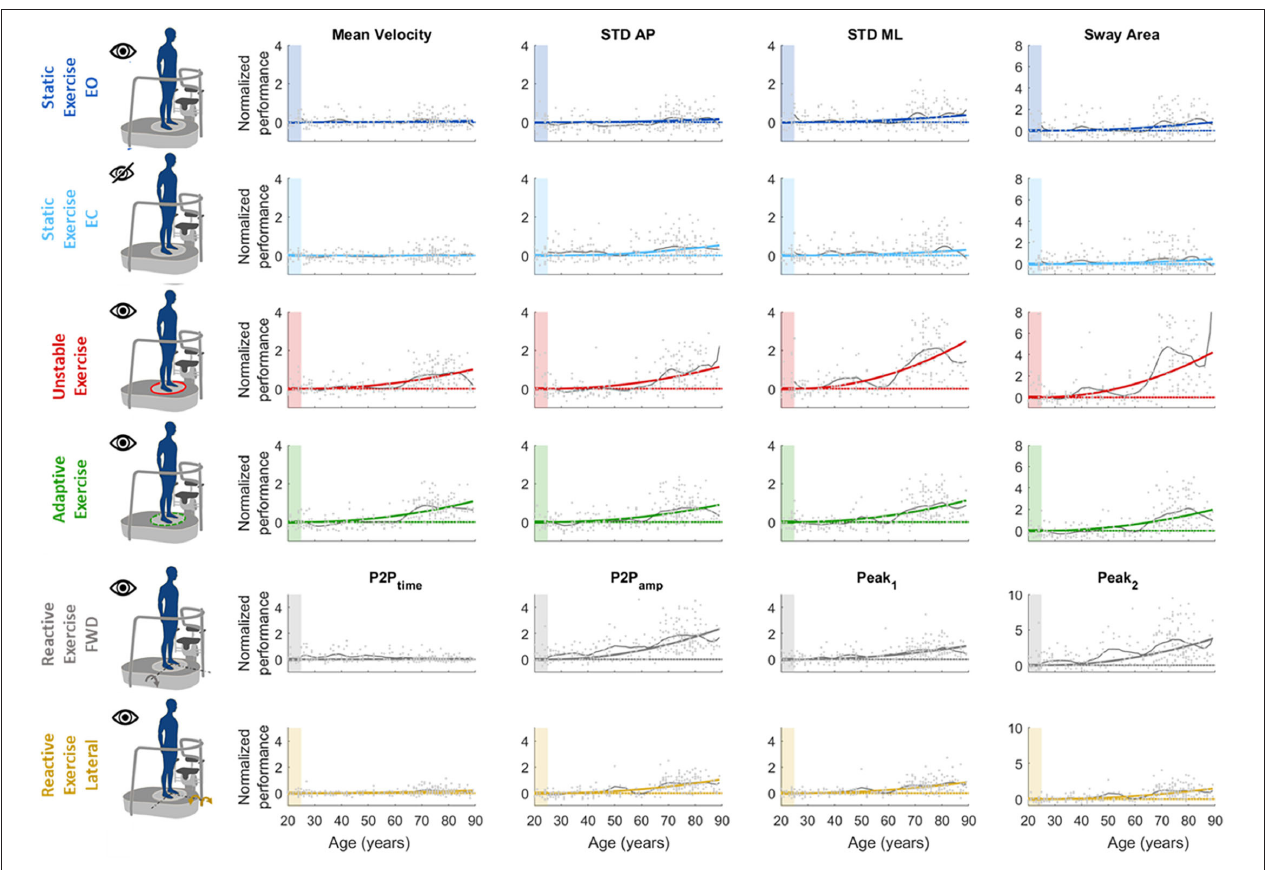
FIGURE 4 | Computed parameters for all the performed tests. Each graph represents how each single parameter changes with age [ x- axis: age (years), y -axis: normalized performance indexes]. In each graph, dots represent single subjects’ performance; colored line is the parabolic fitted curve; black line represents the age by age mean curve; dashed color line is the reference performance ( y = 0). The colored shaded patch highlights the reference age windows used for normalization (age between 20 and 24). Each row is relative to a different test: namely (from top to bottom) static EO, static EC, unstable, adaptive, reactive exercise (forward and lateral perturbation). Each column is relative to a specific computed parameter, namely, (from left to right) mean velocity (MV), STD AP, STD ML, sway area (SA, for test 1–4), and P2P time , P2P amp , Peak 1 , and Peak 2 , (for test